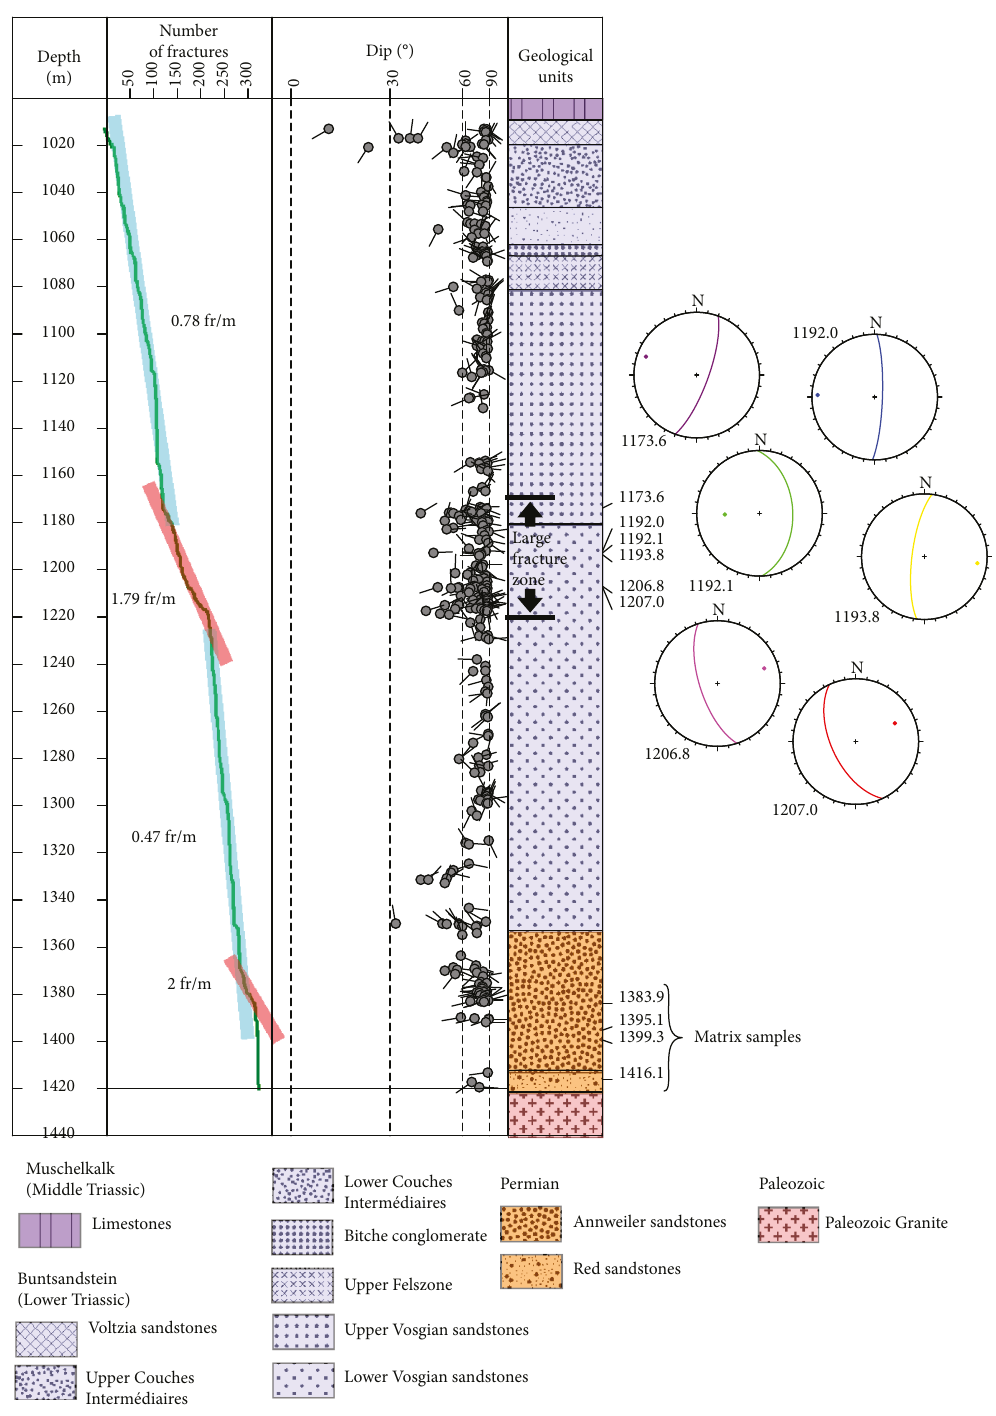
Figure 5: Composite log of Permo-Triassic sandstones in the EPS1 well. The fi rst column represents the measured depth; the second, the cumulative fracture log; the third, the fracture orientation; the fourth, the geological units [115]. Sample locations are shown. The orientation (great circle and pole) of sampled fractures is represented in Schmidt ’ s projection, lower